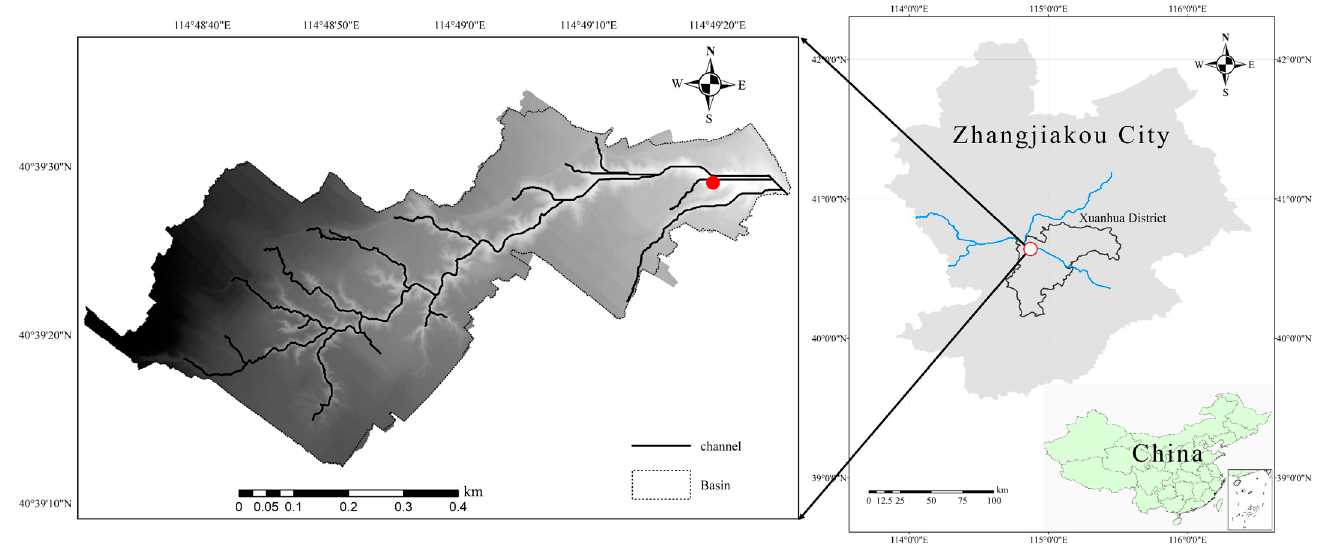
Figure 1. The location of the study gully area which is located in Xuanhua district, Zhangjiakou City, Hebei Province, China. The red dot represents the experimental station in the gully area.